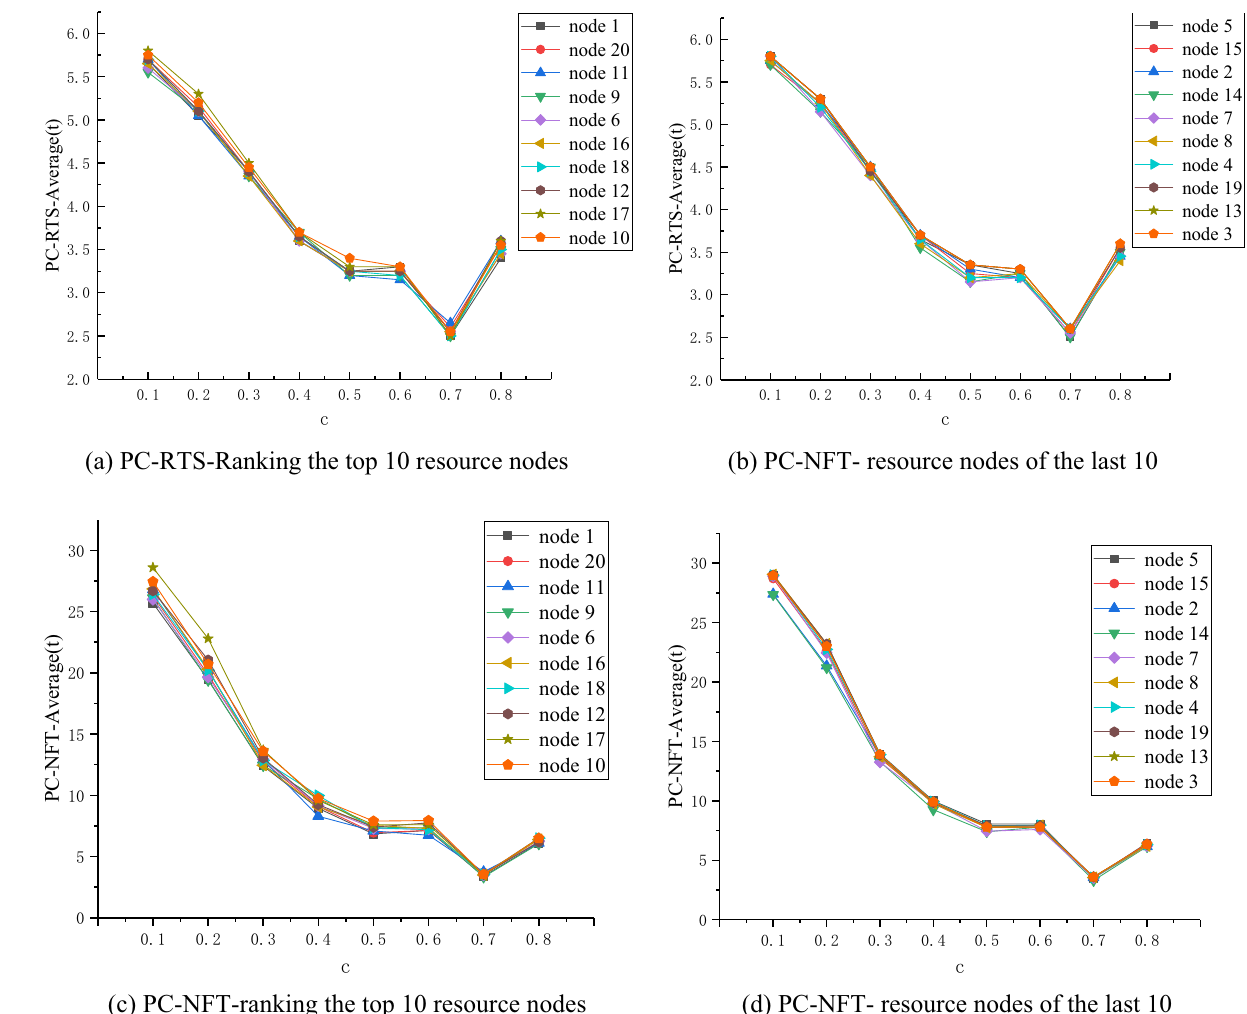
Figure 5. Network performance curve for R = 5 and c = 0.1, 0.2, 0.3, 0.4, 0.5, 0.6, 0.7,